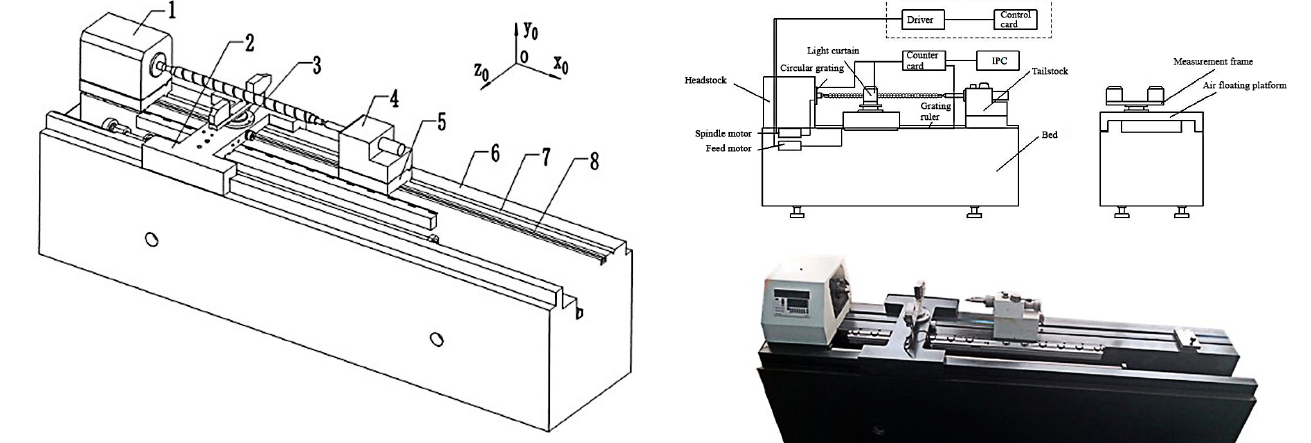
Figure 1. The mechanical structure: (1) the headstock; (2) the air floating platform; (3) the measurement frame; (4) the tailstock; (5) the V-shape cushion block; (6) the bed; (7) the V-sharp track; (8) a groove used to fix the tailstock.